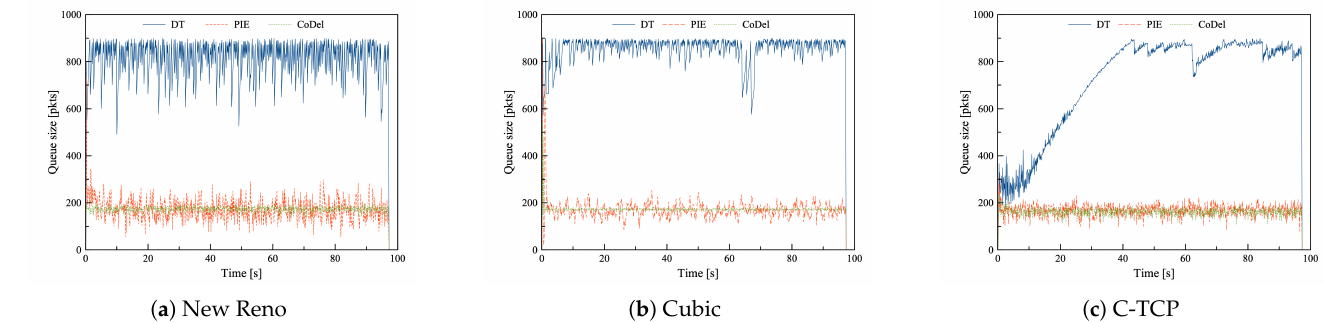
Figure 2. The queue length of DT, PIE and CoDel in combination with ( a ) New Reno, ( b ) Cubic, and ( c ) C-TCP in the Data center scenario with common TCPs in uncongested network.